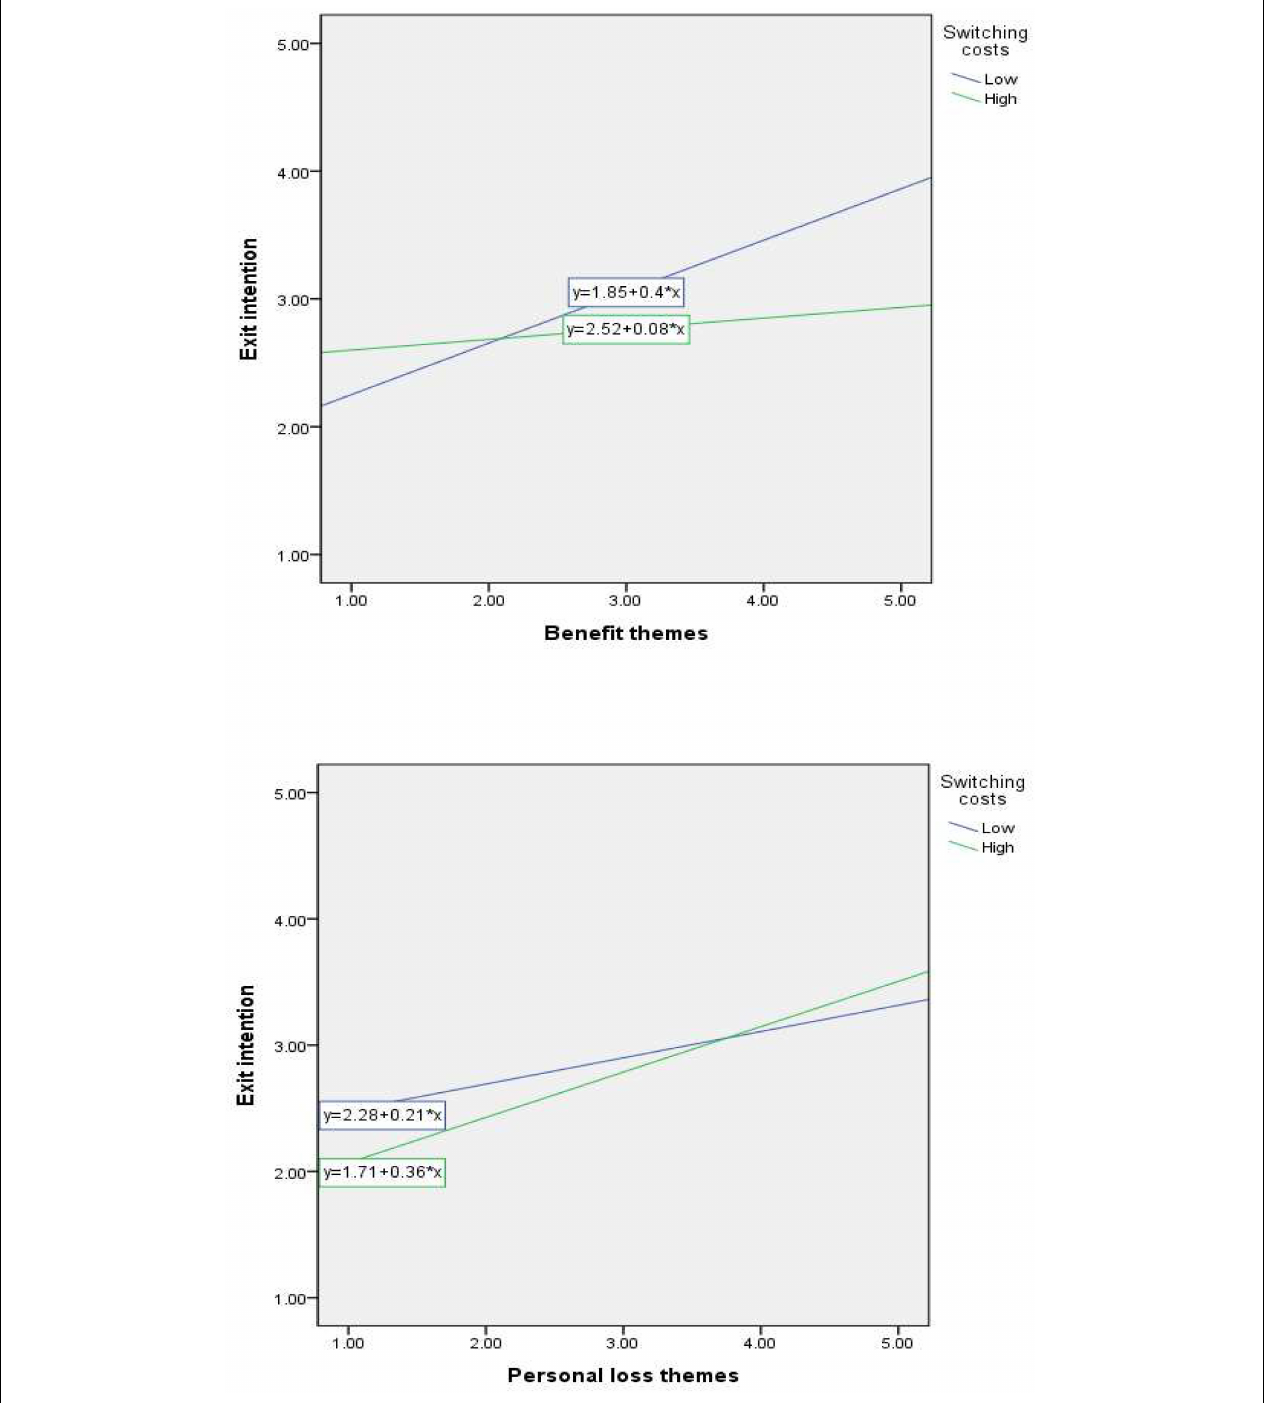
FIGURE 3 | (A) The moderating role of switching costs (H3: Upkeep). (B) The moderating role of switching costs (H3: Time). (C) The moderating role of switching costs (H3: Benefit). (D) The moderating role of switching costs (H3: Personal loss).